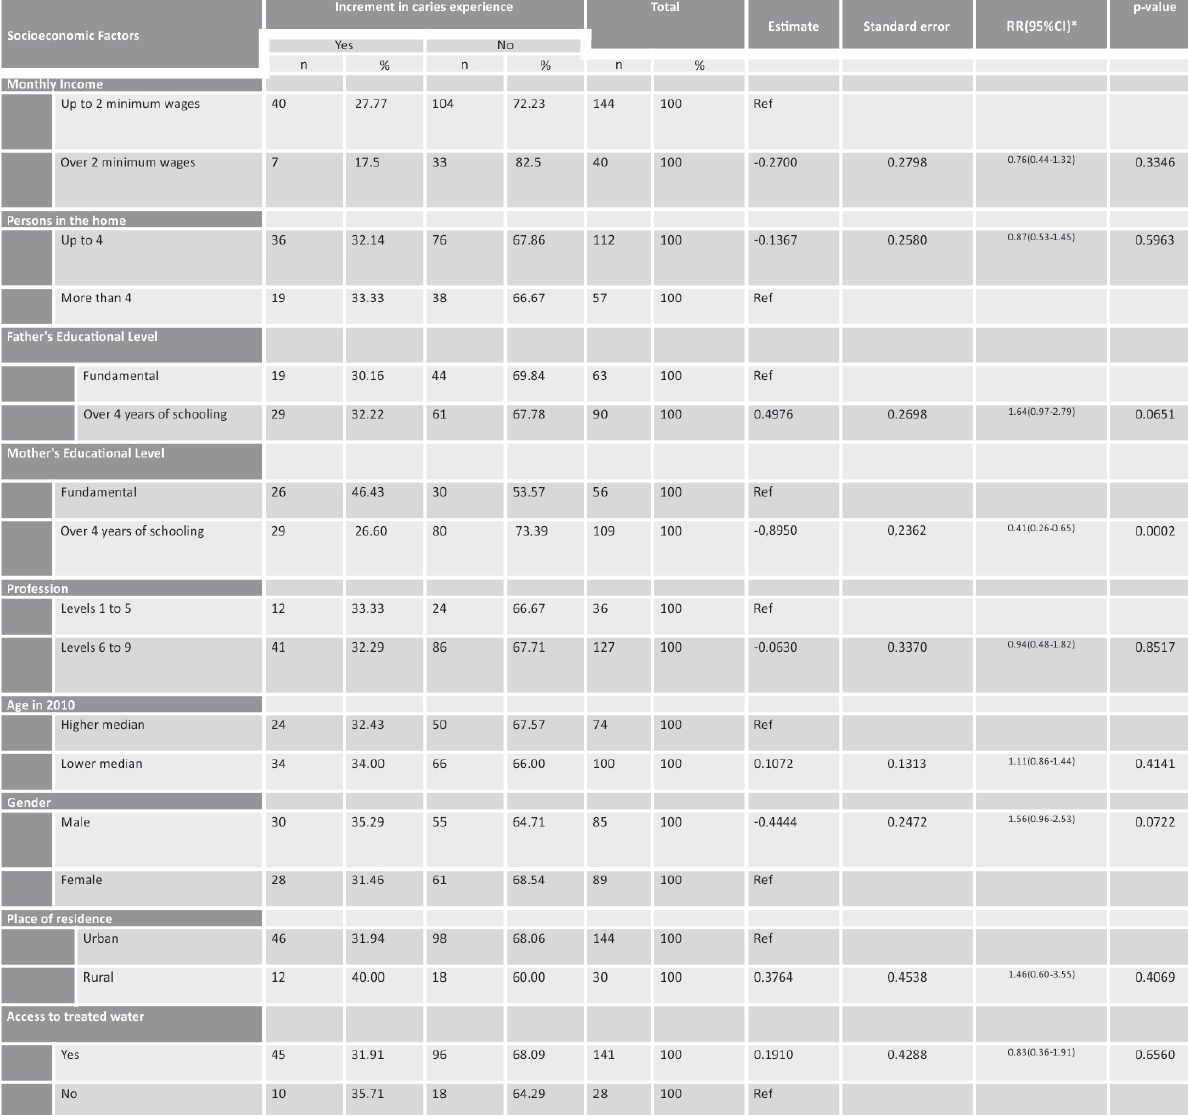
Table 1. Association between socioeconomic and demographic factors and incidence of dental